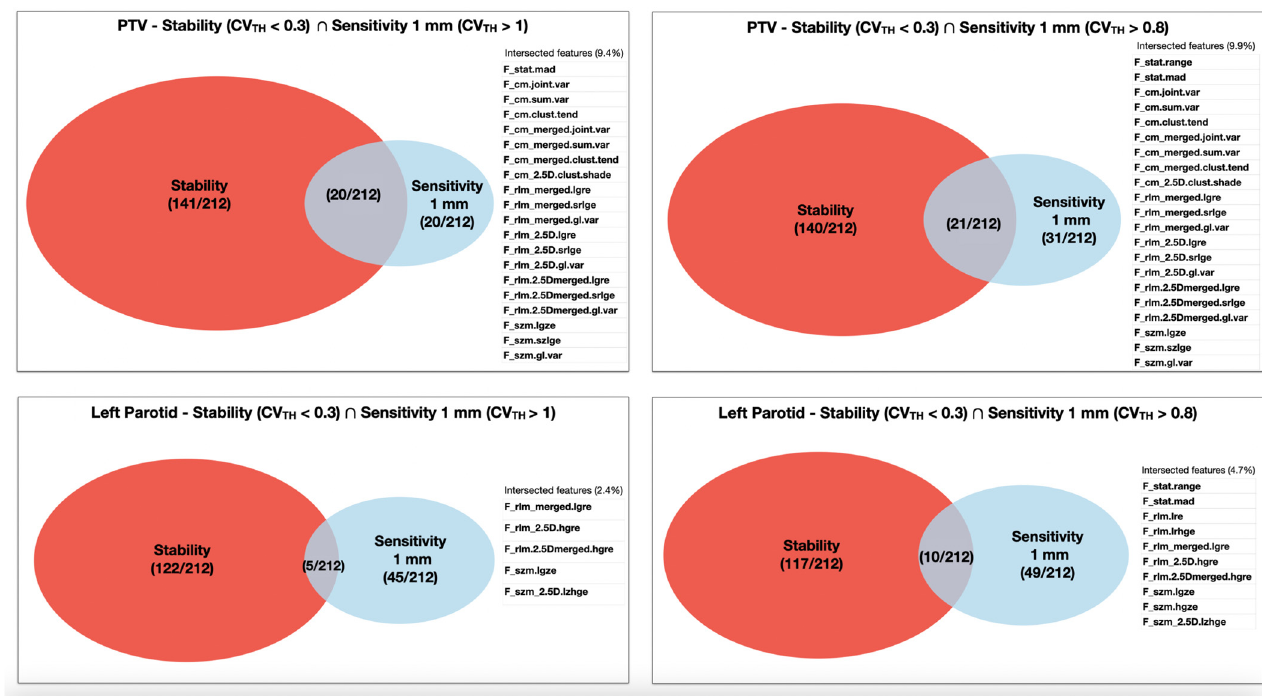
Figure 6. Venn diagrams showing the dosiomic features that are both stable and sensitive between the stability and sensitivity study for the PTV and left parotid. The sensitivity CV threshold was set to two different values: CV TH > 1 and CV TH > 0.8 for the PTV.